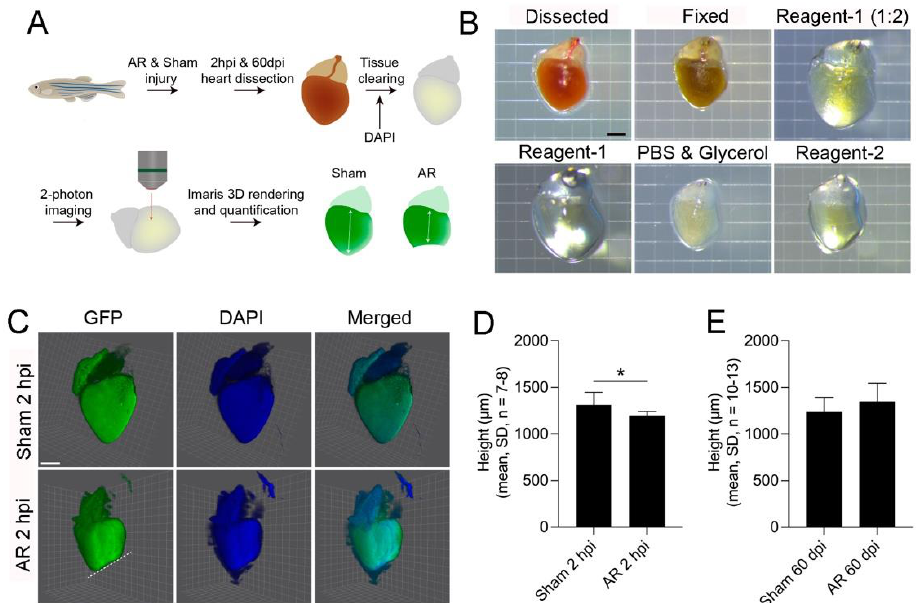
Quantification of heart outgrowth using 3D-analysis of whole zebrafish hearts. ( A ) Schematic of the experiment design from heart dissection through tissue clearing to Imaris analysis of 2-photon images. ( B ) Stereomicroscopy of a zebrafish heart during the different stages of tissue clearing with ScaleCUBIC reagent-1 and -2 [29]. Scale bar: 500 µ m. ( C ) 3D images of sham operated or apex resected tg(myl7:EGFP) zebrafish hearts, expressing green fluorescense protein (GFP) under the control of the cardiac myosin light chain 2 promoter, thus marking the myocardium (green) 2 h post injury (hpi). Hearts were co-stained with 4 (cid:48) ,6 (cid:48) -diamidino-2-phenylindole (DAPI, blue) and images generated by Imaris. Scale bar: 500 µ m. ( D , E ) Based on the IMARIS analysis, the height of the heart was measured from base to apex in sham operated and apex resected zebrafish hearts, ( D ) 2 hpi and ( E ) 60 days post injury (dpi). Statistical analysis included: Normality was tested followed by a Student’s t -test, * p ≤